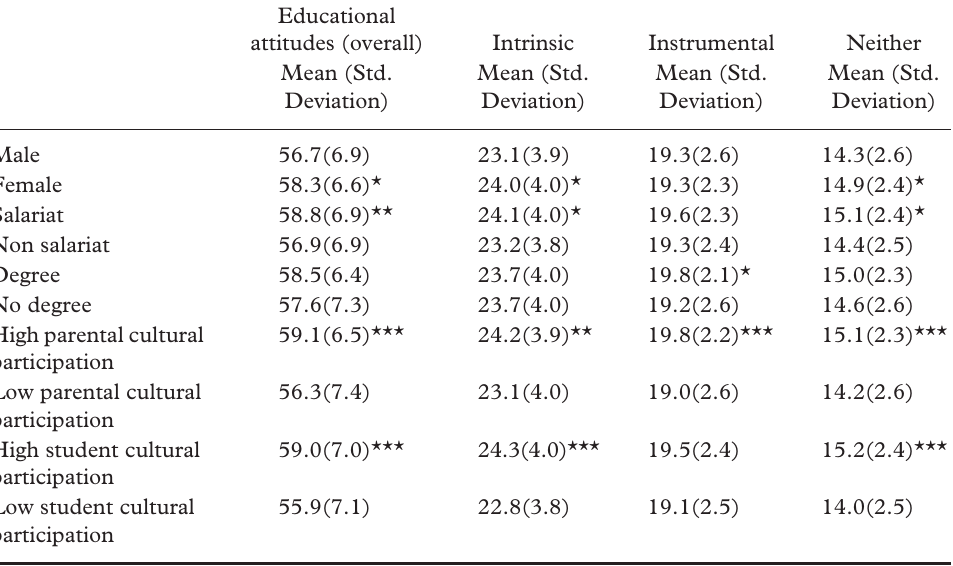
Table 1. Students’ attitudes to education—mean